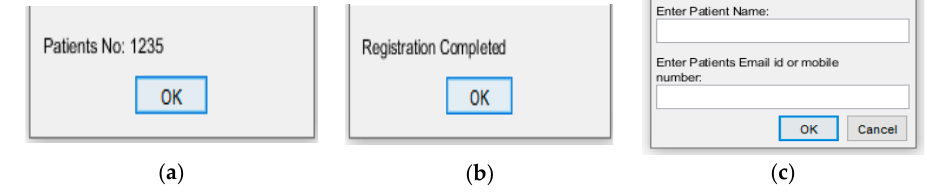
Figure 8. Execution results: ( a ) Patient no ( b ) Registration completed ( c ) Patient login.